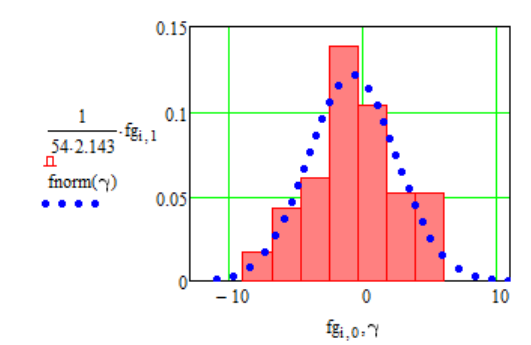
Fig. 2. Construction of a histogram of γ values and its approximation based on the Gaussian law.